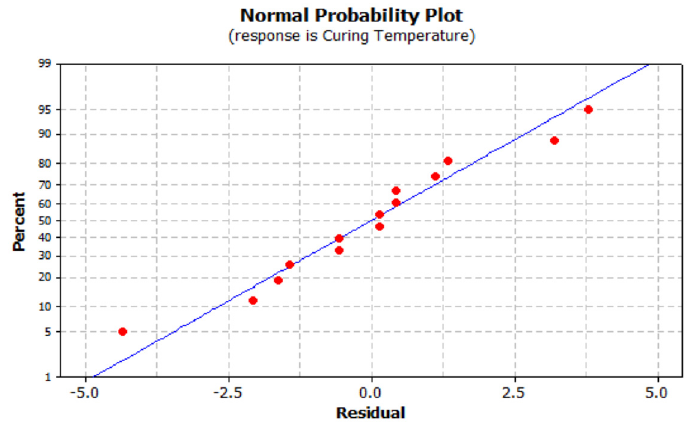
Figure 6. Normal probability plot for curing temperature (response).